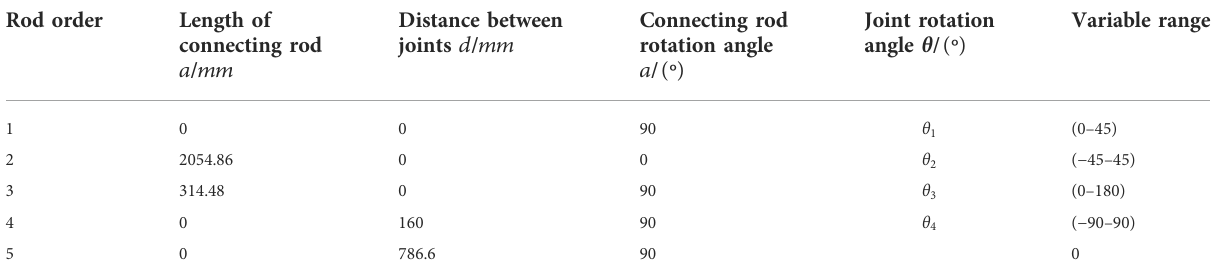
TABLE 1 D − H parameters.